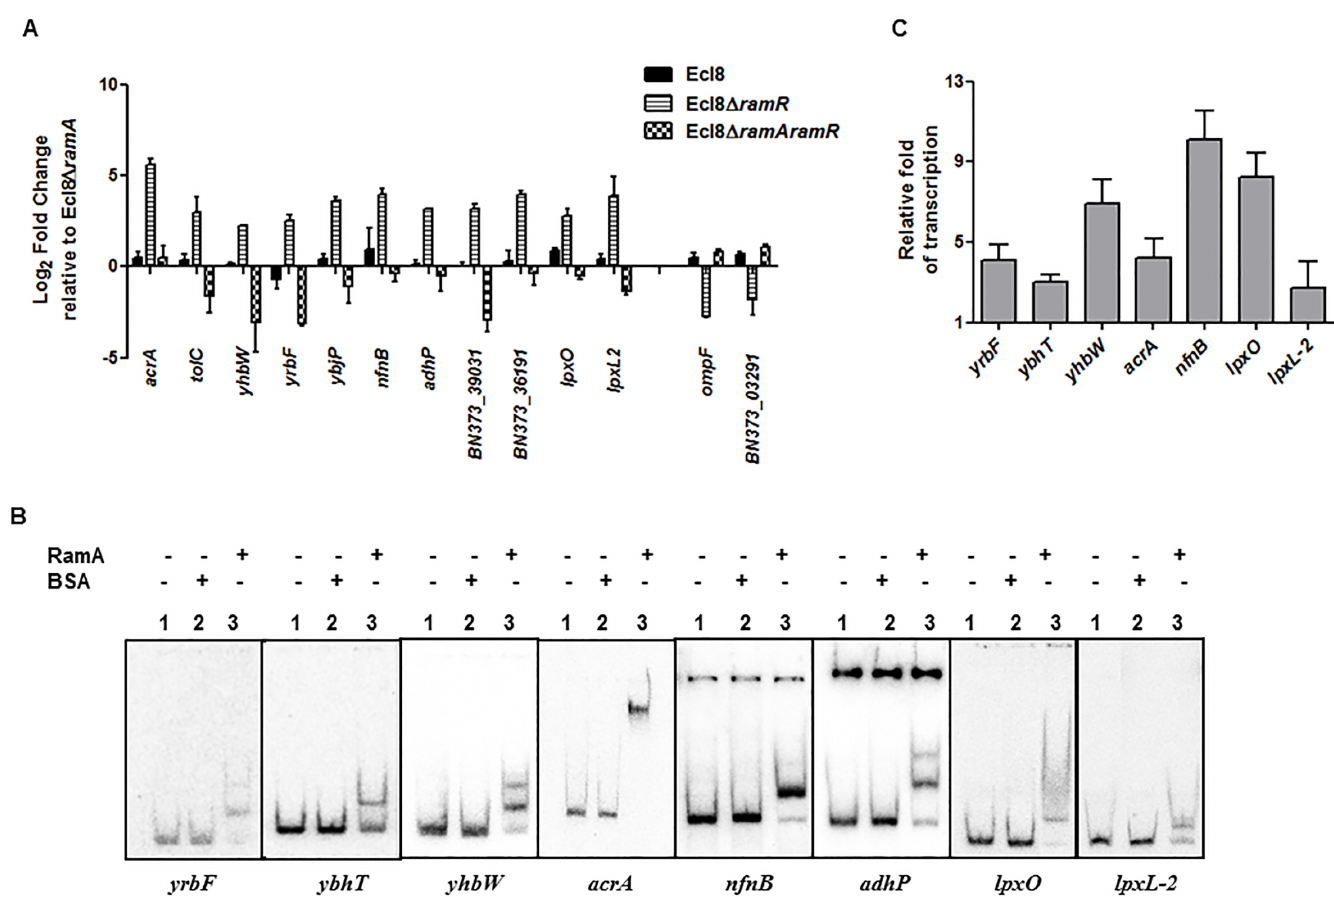
Fig 4. A: Quantitative real-time RT-PCR validation of differentially expressed genes in Ecl8 Δ ramR . All qPCR experiments were performed as outlined in materials and methods. Expression levels were normalized to 16S levels, and fold change values were generated by calibrating against Ecl8 Δ ramA . Genes designated BN373_36191, BN373_39031, BN373_03291 encode a putative membrane protein, oxidoreductase family and conserved hypothetical protein respectively. All data is a mean of 3 experiments. B: Electrophoretic Mobility Shift Assay (EMSA) using purified RamA protein. Following PCR amplification, each promoter region was end-labelled with 32 P- γ ATP. Purified RamA (200 nM) and the different labelled DNA probes (2 nM) were incubated on ice. All reactions were performed on ice prior to electrophoresis on 7.5% native gel. Lane 1 of each panel indicates the labelled